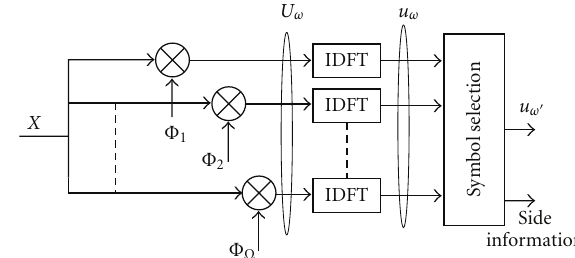
Figure 6: Block diagram for the selective mapping PAPR reduction technique.